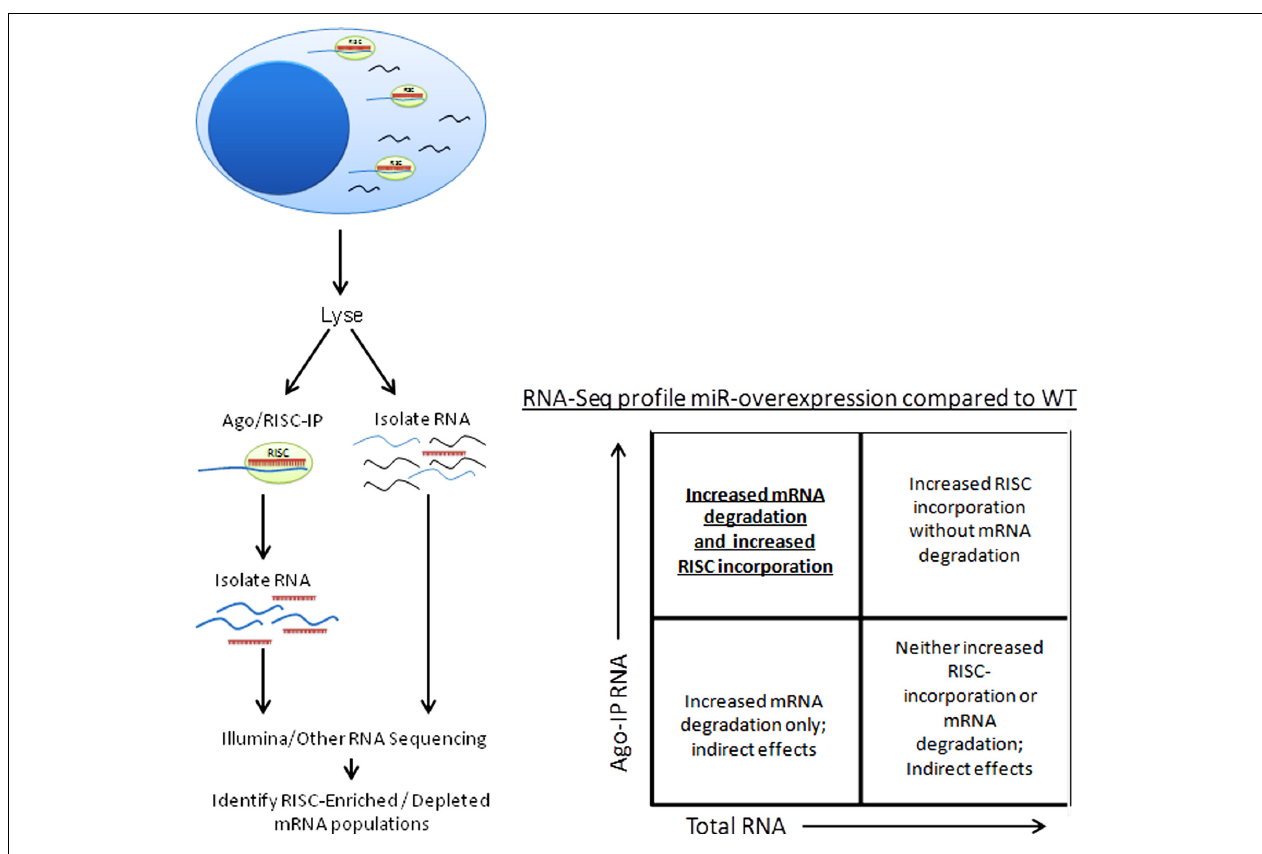
FIGURE 4 | Schema ofArgonaute/RISC immunoprecipitation procedure and